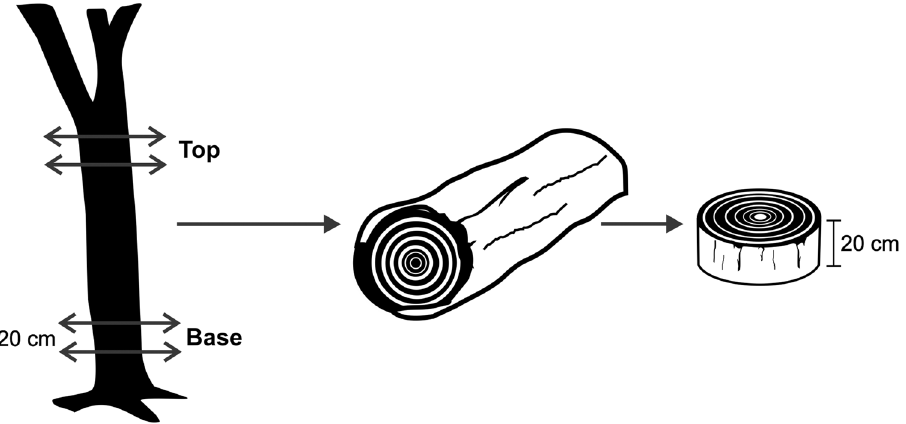
Figure 1. Wood sampling